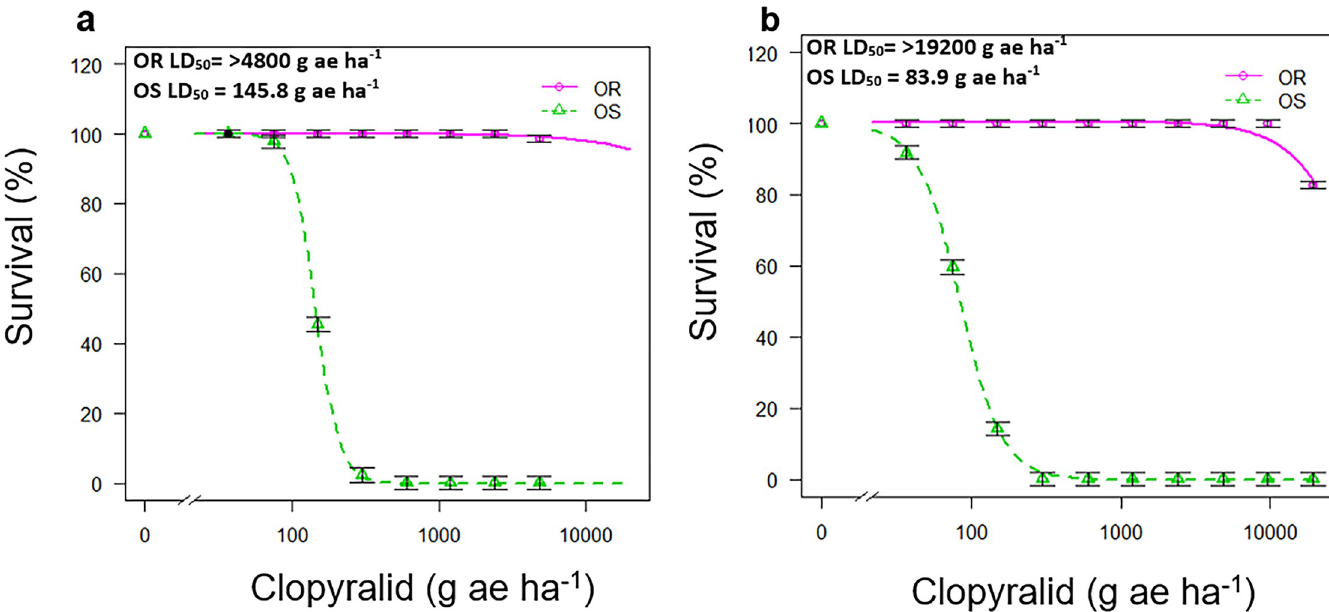
Fig 1. Fitted clopyralid dose-response curves for two S . sessilis populations, the resistant population OR and the susceptible population OS in (a) the first and (b) second dose-response experiments. The percentage of survival of treated plants was used to produce the fitted curves. Vertical bars represent ± standard error of the mean.